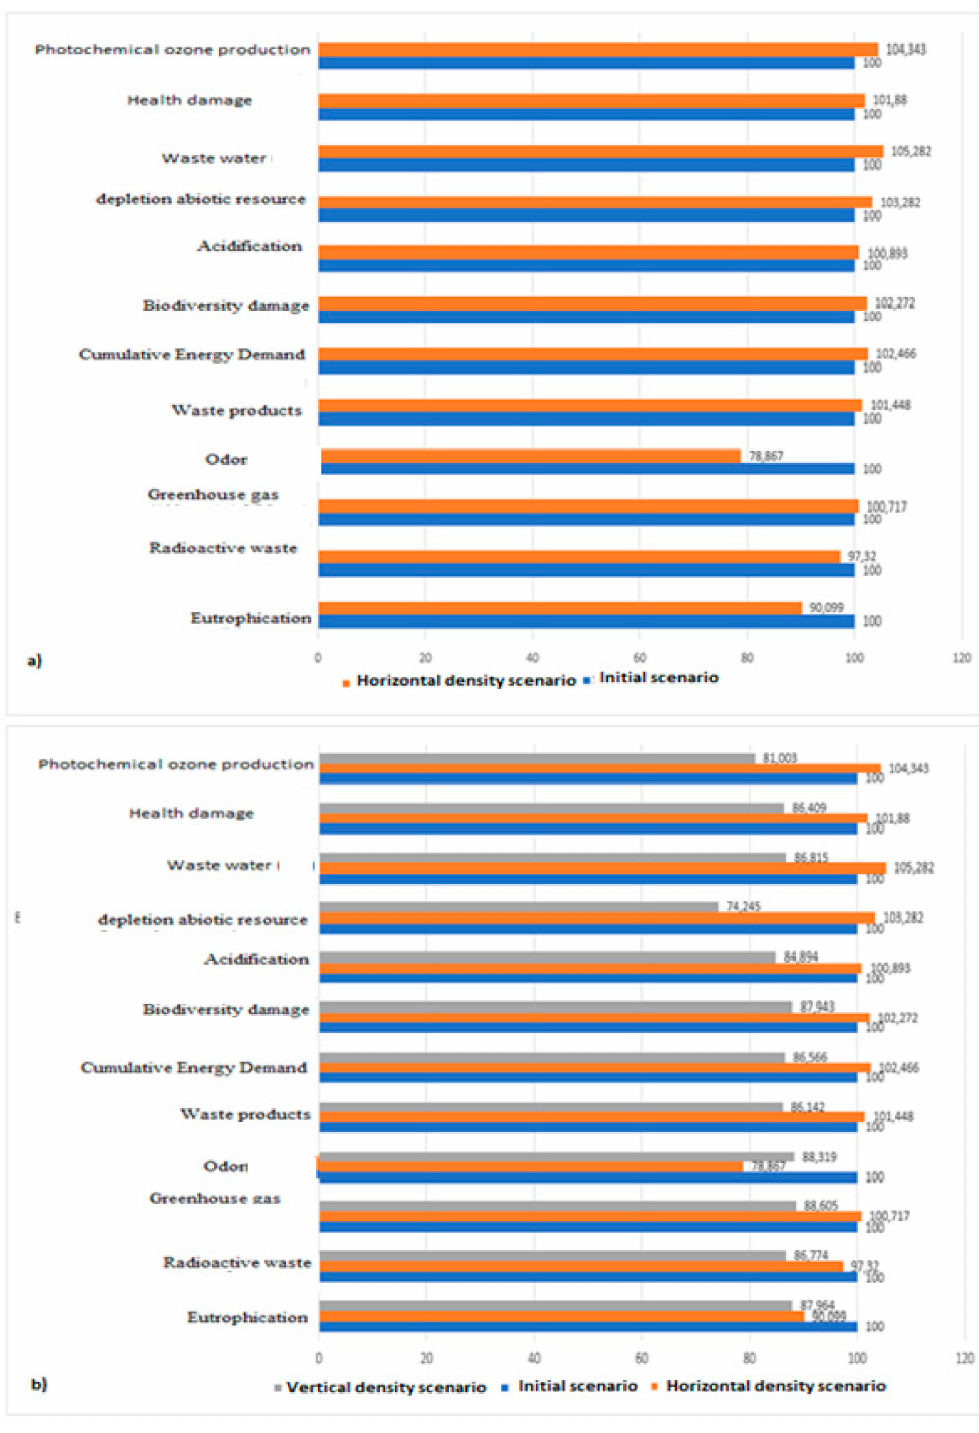
Figure 13. Comparative diagram of the environmental impacts of the “Initial” and “Horizontal Density” scenarios ( a ); and “Initial”, “Horizontal Density” and “Vertical Density” (functional unit: occupant) ( b ). Some results are showed on the Table